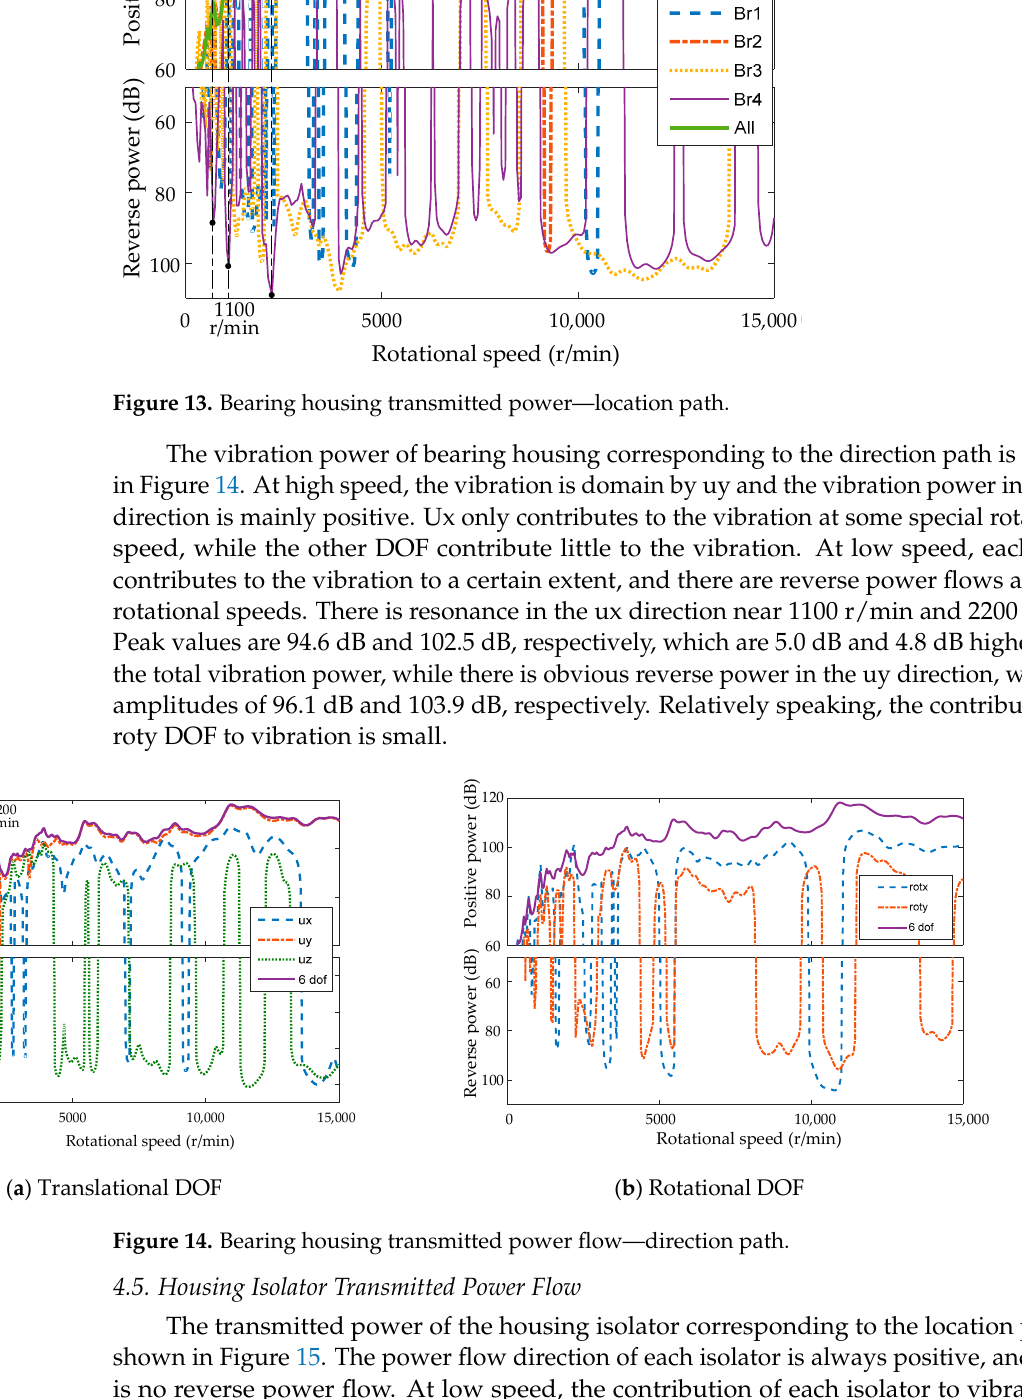
( b ) Isolator 4, 5, 6 Figure 15. Housing isolator transmi tt ed power—location path. The transmi tt ed power corresponding to the direction path is shown in Figure 16. The direction of power in ux, uy, uz, and roty DOF are constantly positive. There are reverse power fl ows in rotx and ro tz directions at very few rotational speeds. On the whole, the vibration power of the isolator is mainly in the vertical direction uy, and ux and uz also contribute to a certain extent at low speed. Ux has a resonance peak near 8400 r/min with an amplitude of 87.8 dB, which is 5.0 dB higher than the power of uy. Rotx has